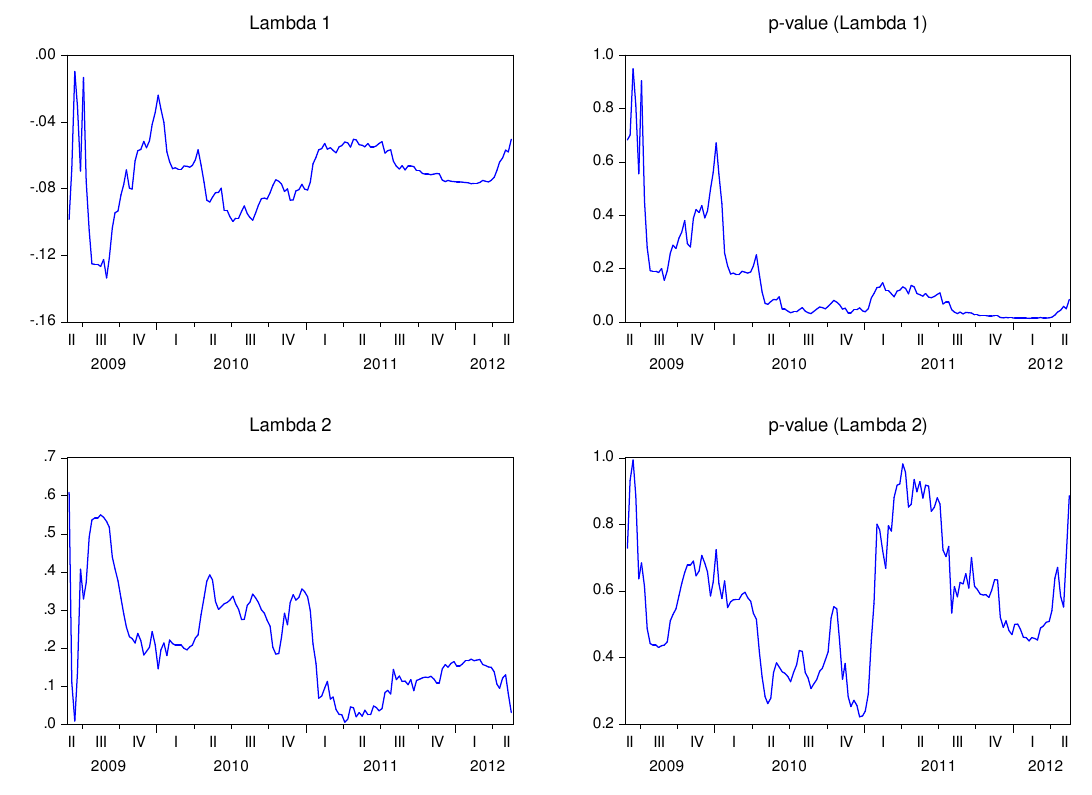
Figure 9. Recursive estimation of the speed adjustment parameters — Spain.